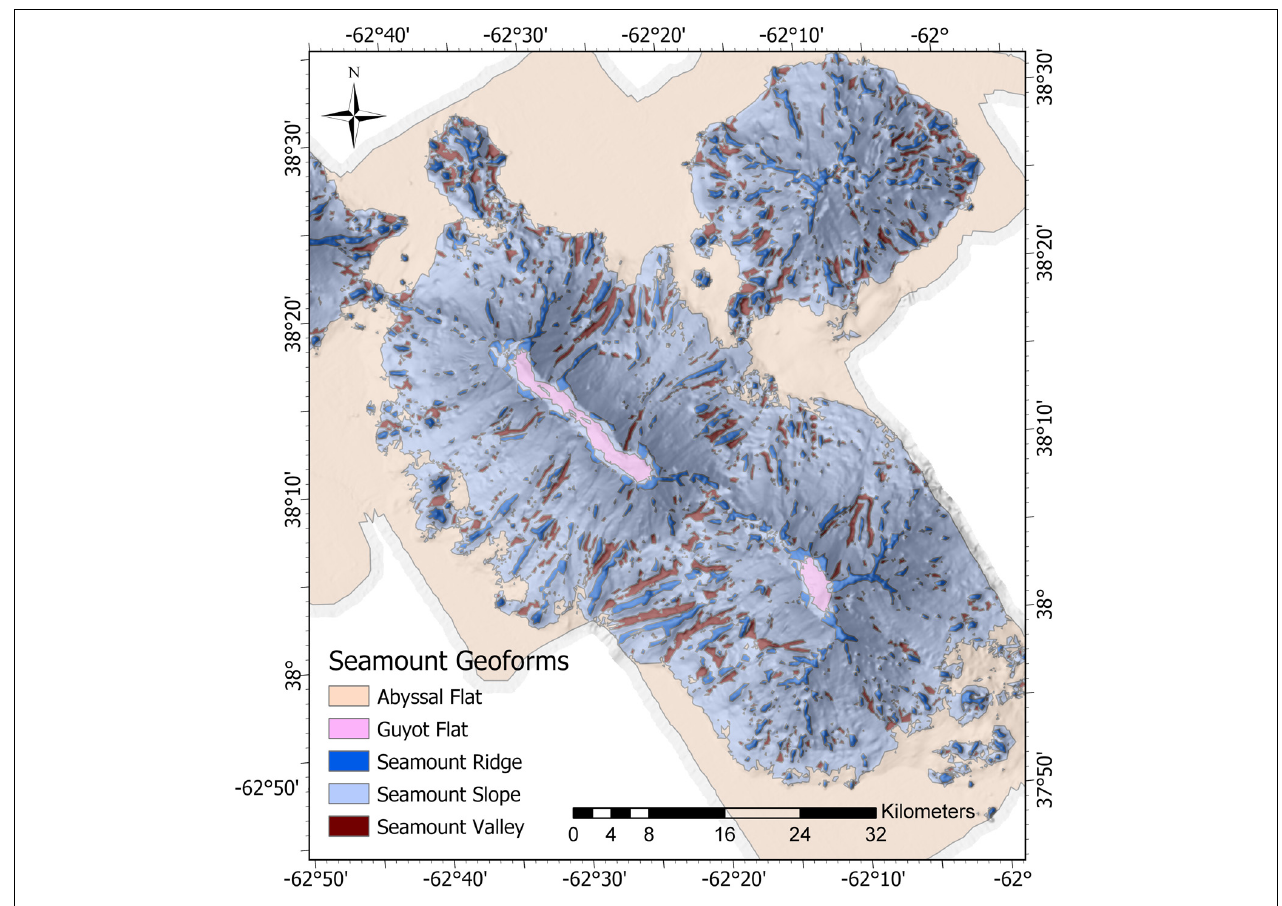
FIGURE 6 | Geoform classes of Gosnold Seamount. A hillshade layer was computed from the bathymetry and is shown with partial transparency to provide depth and context to the figure.